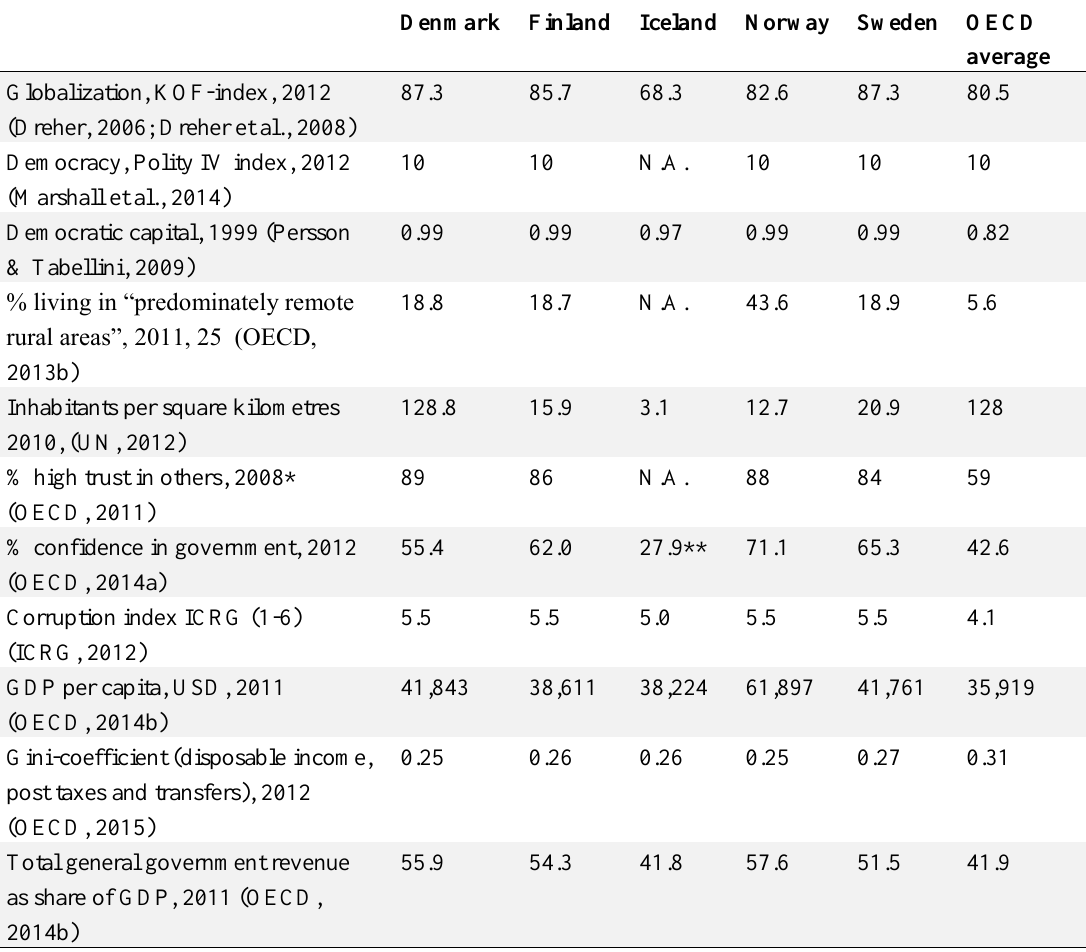
Table 2: The Nordic Health care systems in context